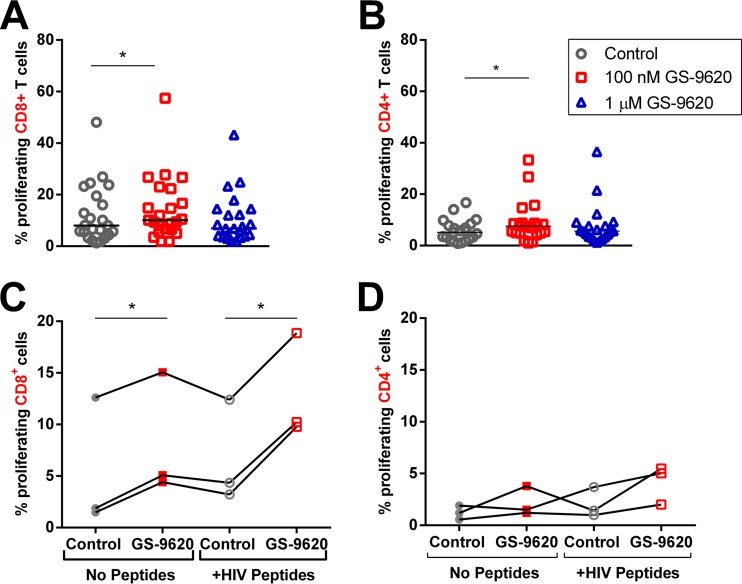
GS-9620 enhances proliferation of HIV-specific CD8+ and CD4+ T cells. CFSE-labeled PBMCs were isolated from ART-suppressed HIV-infected individuals (n = 23) and stimulated in duplicate with a pool of HIV peptides (derived from Gag, Nef, Env, and Pol) with or without GS-9620 for 8 days. The cells were treated a second time with the same HIV peptides, stained for activation, and analyzed by flow cytometry. (A) Scatter plots showing the percentages of proliferating (CFSE dim) CD8+ and CD4+ T cells. The cells were treated with vehicle control, 100 nM GS-9620, or 1 μM GS-9620. Each symbol corresponds to the data from a single subject, with the horizontal bars indicating medians. (B) For a subset of CD8 and CD4 cells from individuals that proliferated in response to GS-9620 and HIV peptides, the cells were similarly treated, but without HIV peptide stimulation. The lines connect results obtained from the same individual. The P values were determined by paired Student's t tests. *, P < 0.05.